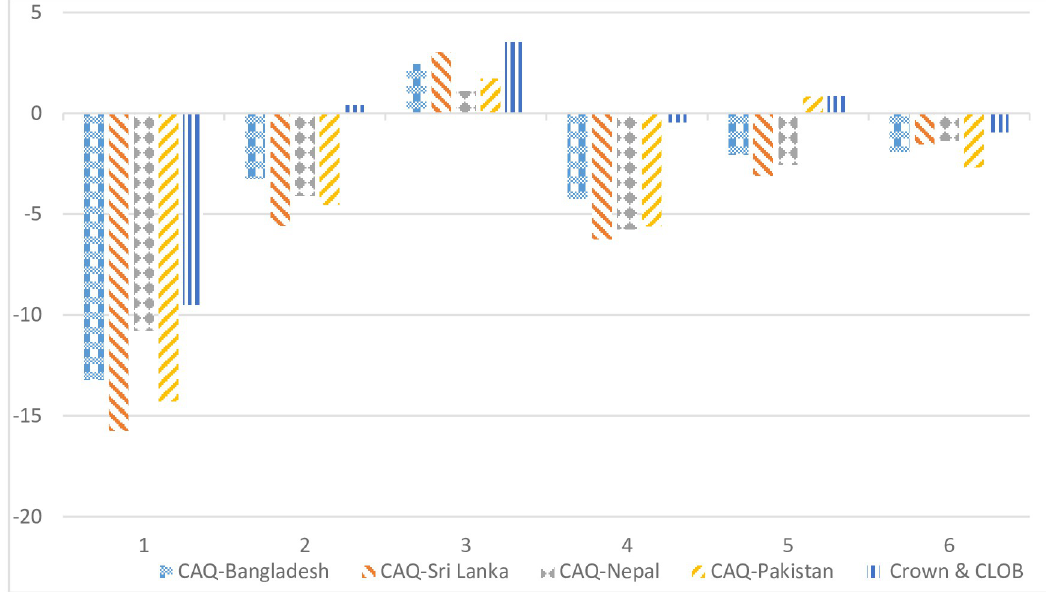
Fig 2. Dimension differences among four sub-corpora and reference corpus in 6